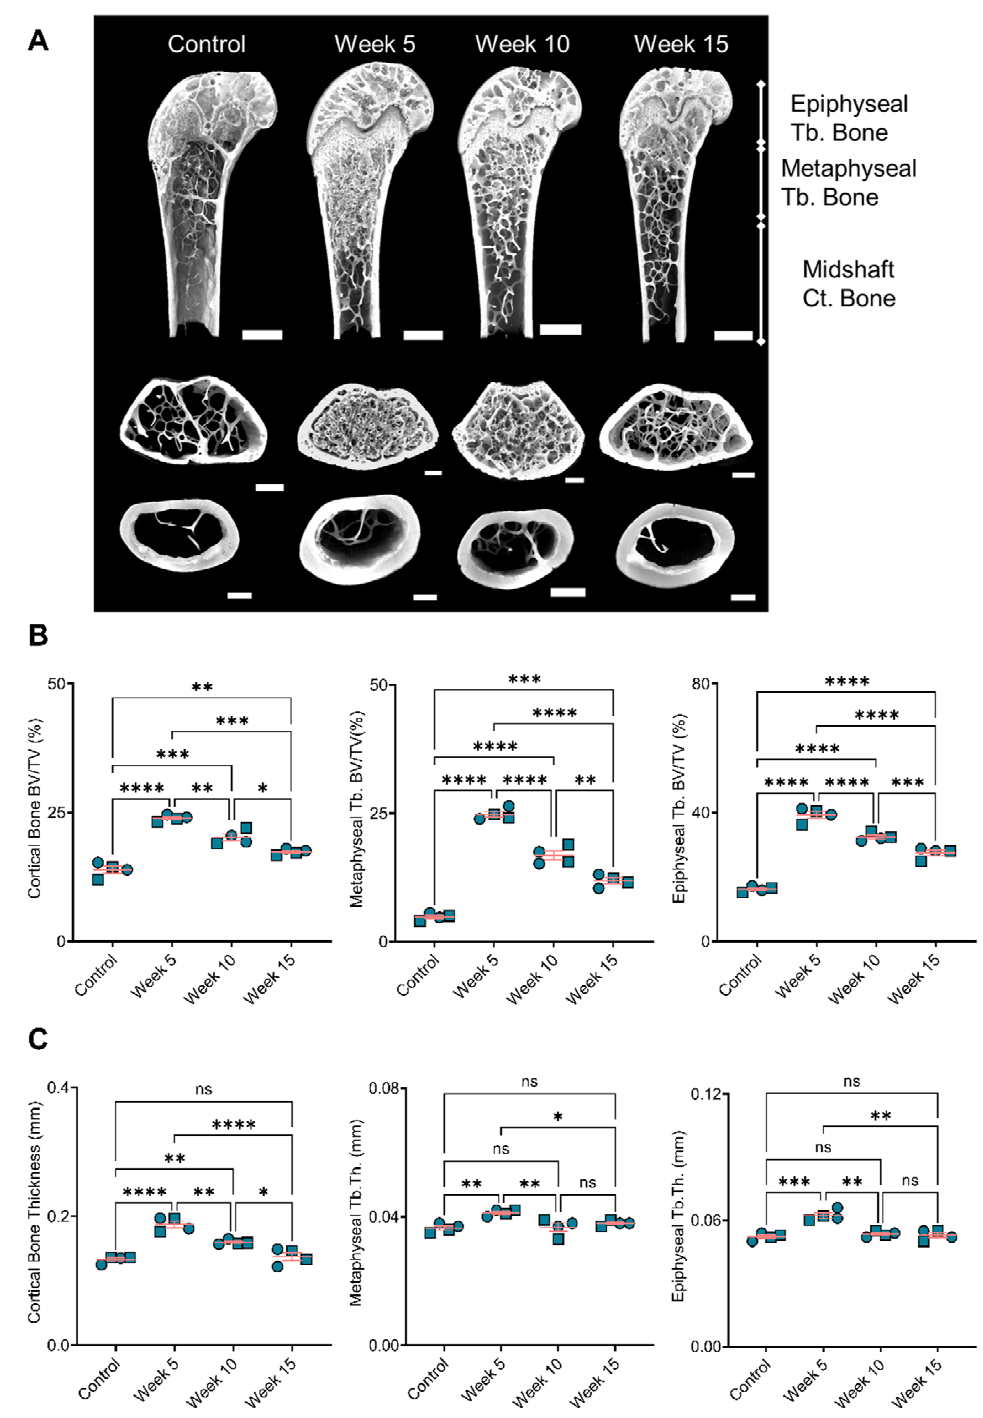
Figure 6. Bone remodeling positively correlated with duration of BiP treatment. ( A ) Reconstruction of femoral bone microstructure for the different treated and untreated groups; Panel ( B ) is the bone volume fraction (bone volume/total volume) for the cortical and trabecular regions; Panel ( C ) is the bone thickness for the cortical and trabecular regions. * p < 0.05, ** p ≤ 0.01, *** p ≤ 0.001, and **** p ≤ 0.0001, two-way ANOVA with Tukey’s post-hoc test. Male mice ( • ) and female mice ( (cid:4) ). “ns” stands for not